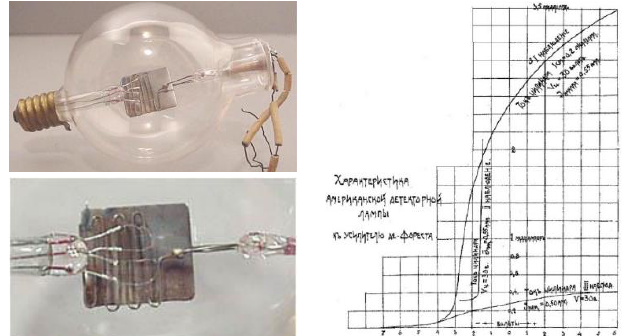
Fig. 10. General view of the “Audion detector” by Lee de Forest and its anode – grid characteristics (1917).